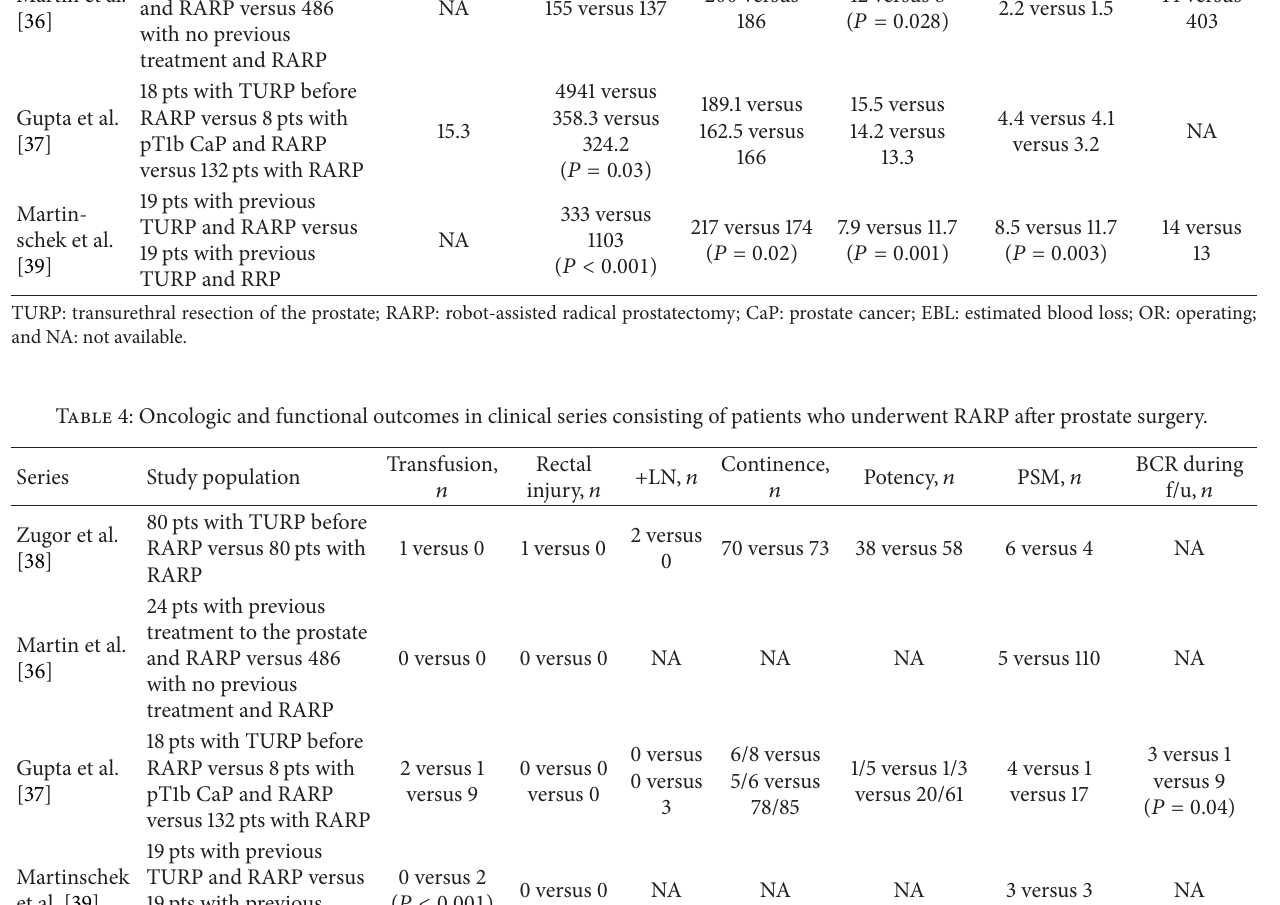
Table 3: Perioperative outcomes in clinical series consisting of patients who underwent RARP after prostate surgery. Series Study population Zugor et al.